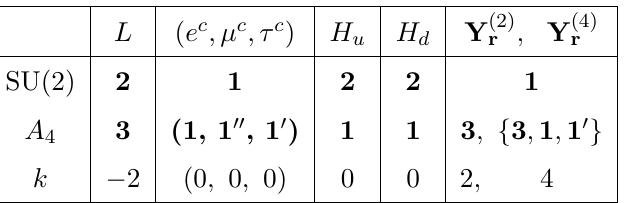
Table 1 . Representations and weights k for MSSM fields and modular forms of weight 2 and 4